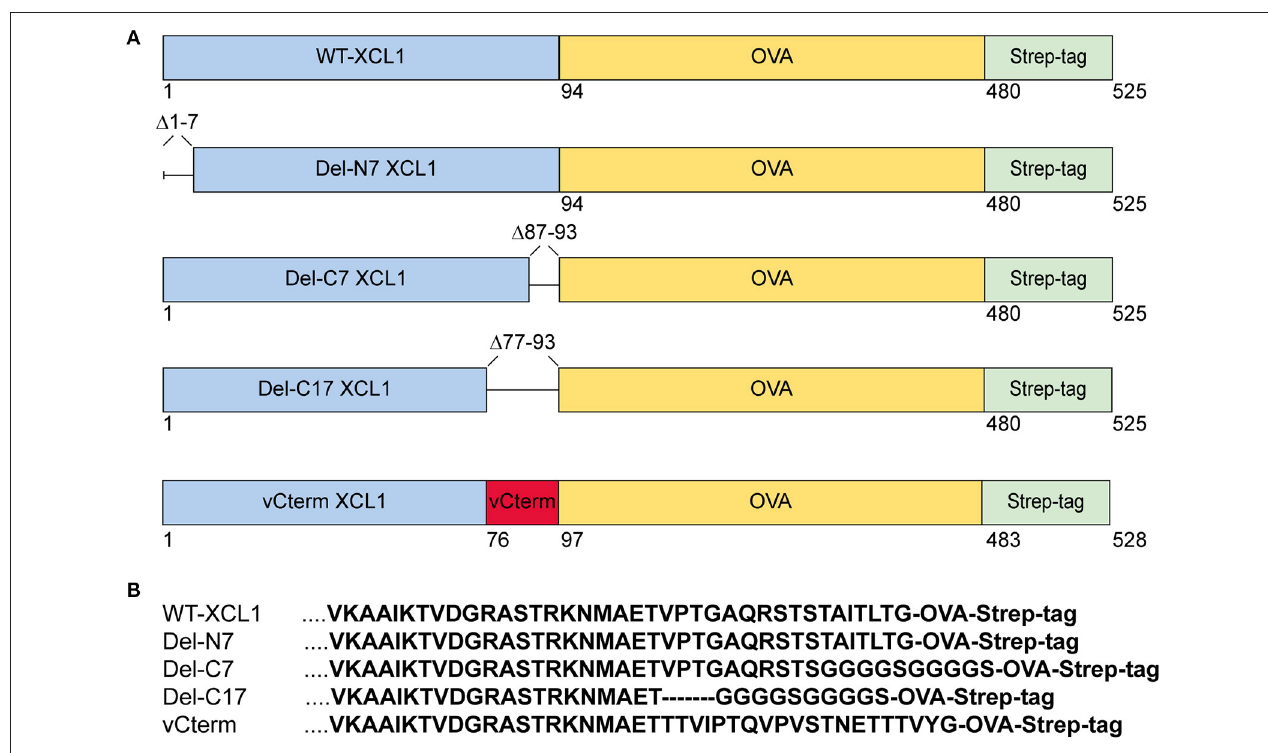
FIGURE 1 | XCL1-OVA and its variants Del-N7, Del-C7, Del-C17, and vCterm. (A) Schematic representation of XCL1-OVA and its variants. Del-N7 lacks the first seven amino acids (aa), in Del-C7 and Del-C17, the final 7 and 17 C-terminal aa were deleted, respectively. In vCterm, the 17 C-terminal aa were replaced by the 20 C-terminal aa of murid herpesvirus 8-encoded XCL1. (B) C-terminal aa sequences of XCL1 in the respective protein variants.